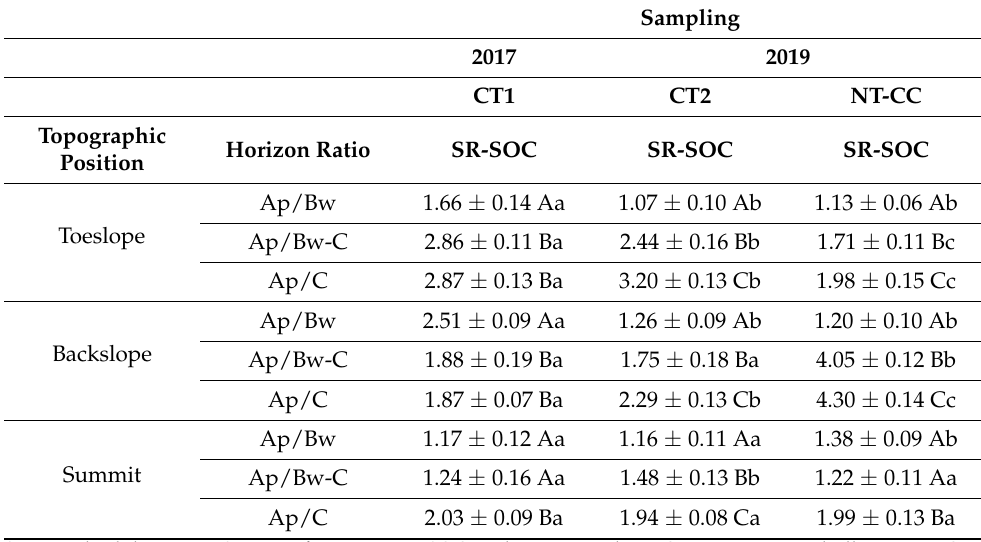
Table 6. Stratification ratio of soil organic carbon (average ± SD) in a Mediterranean olive grove. Initial situation (September 2017) and final situation (September 2019) in three topographic positions (toeslope, backslope, and summit) with two types of management (conventional tillage or no-tillage with cover